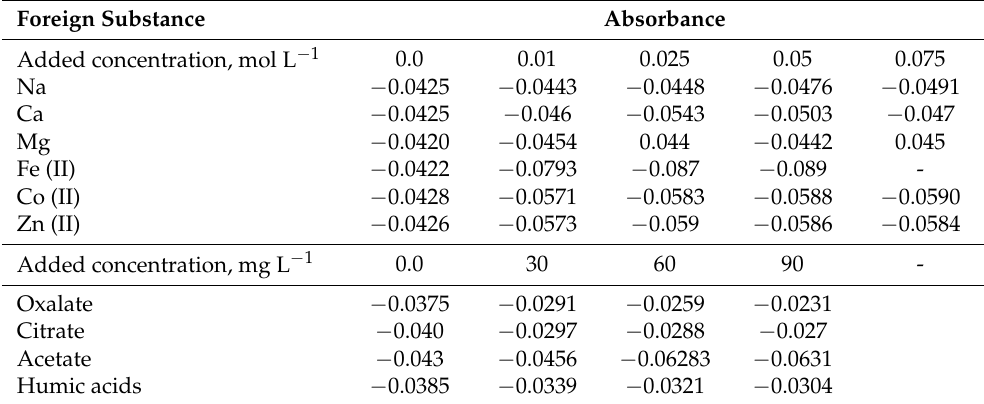
Table 3. Interfering effect of organic and inorganic compounds with the CTAB determination by the